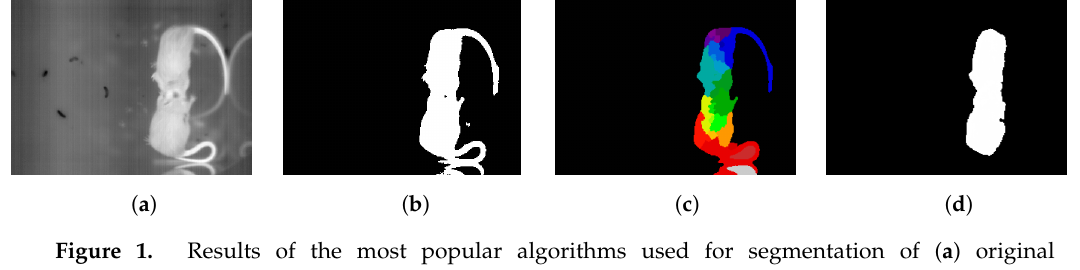
Figure 1. Results of the most popular algorithms used for segmentation of ( a ) original image